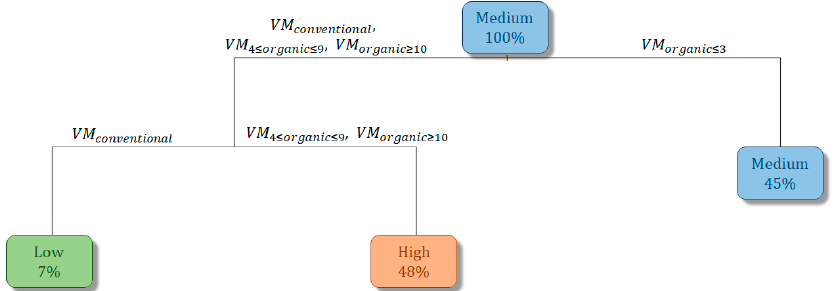
Figure 4. Classification decision tree of soil samples to predict soil biodiversity according to vineyard management. The predicted level of soil biodiversity (low, medium, high) is reported in the squared box, together with the percentage of soil samples included in that node. The paths from the initial box (with 100% of cases) to the final boxes represent the classification rules.